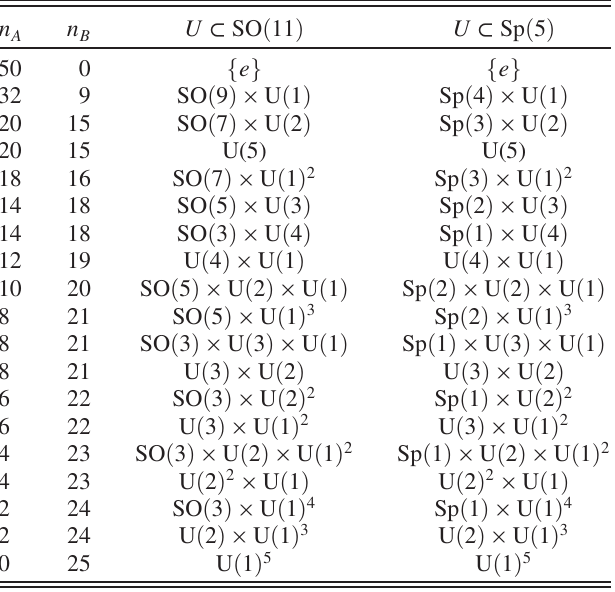
TABLE V. Possible number of type- A and type- B NGBs for SO ð 11 Þ = U ð 1 Þ 5 and Sp ð 5 Þ = U ð 1 Þ 5 .